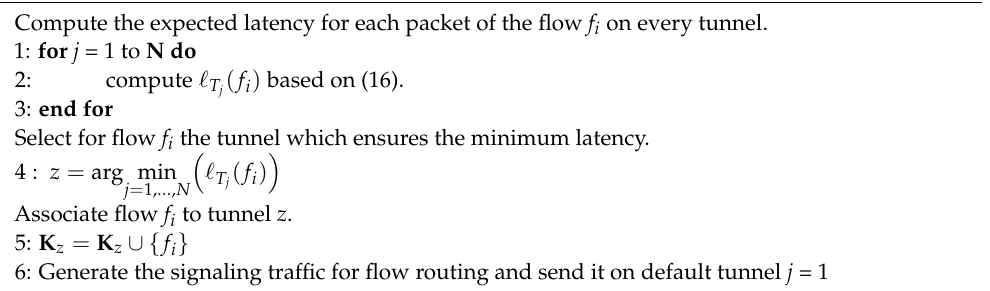
Algorithm 1 Selfish Routing-based LB